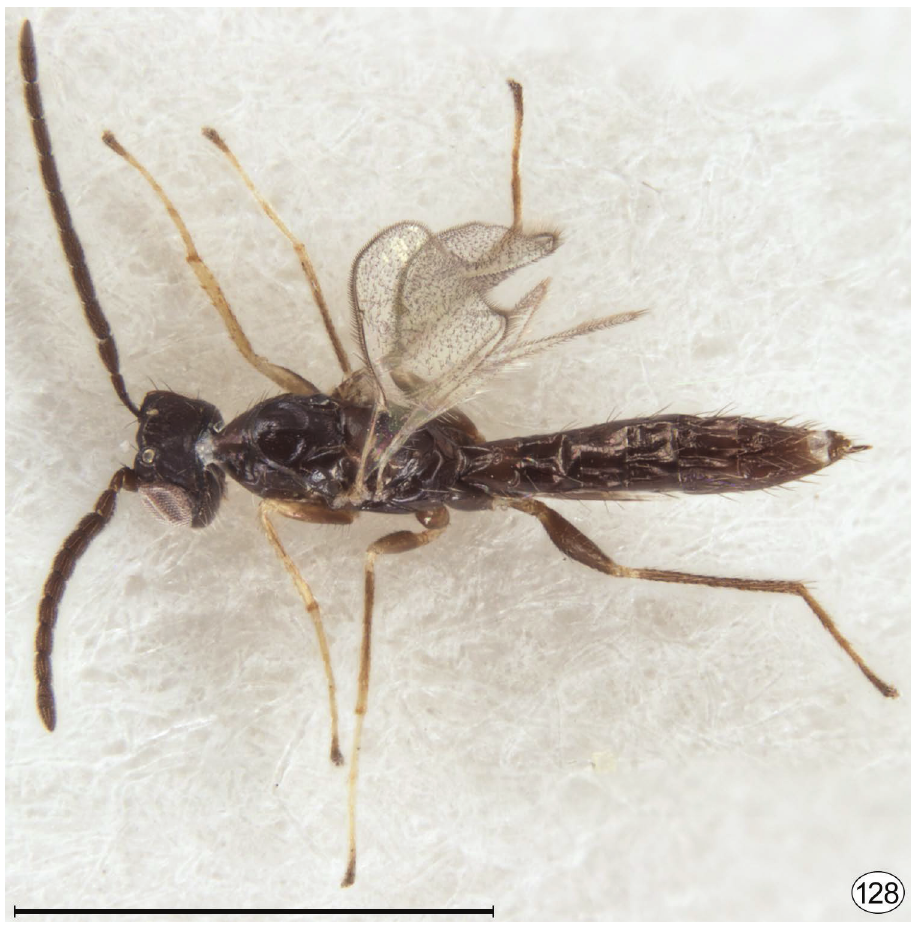
Figure 128. Neotriadomerus powerae , paratype female habitus, dorsal (Brisbane Forest Park). Scale bar = 1000